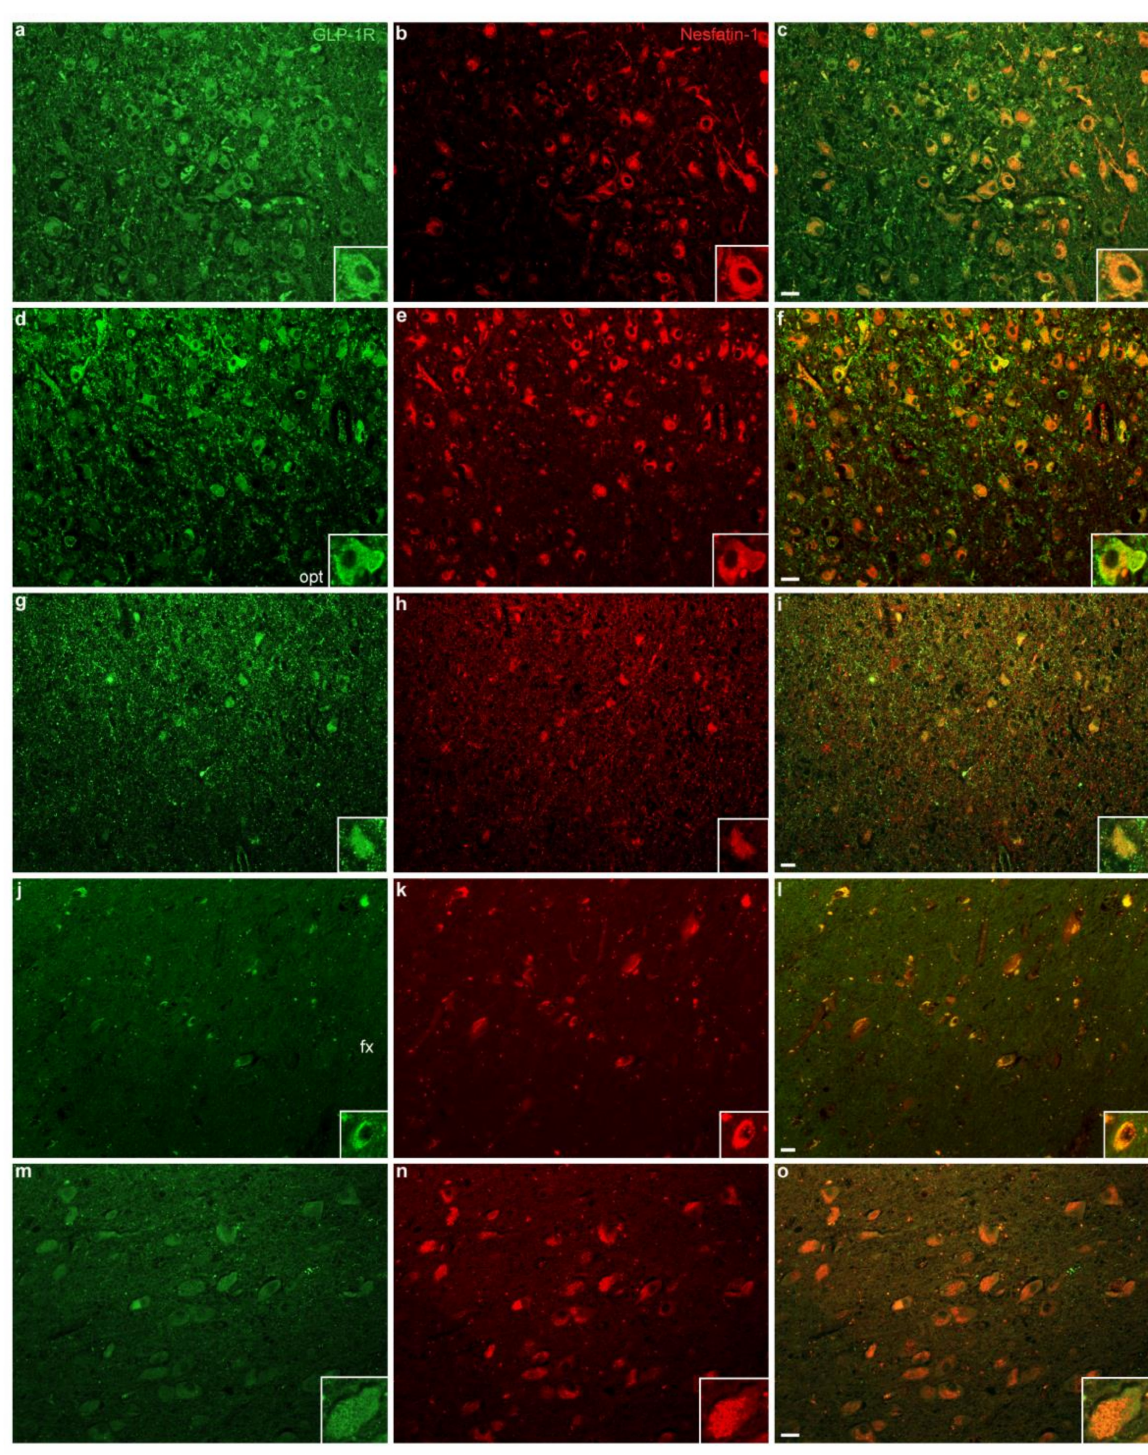
Figure 4. Representative light microscopic fluorescent images depicting GLP-1R and NUCB2/nesfatin-1 colocalization in the human hypothalamus. Representative sections of par- aventricular nucleus ( a – c ), supraoptic nucleus ( d – f ), infundibular nucleus ( g – i ), lateral hypothalamic area ( g – l ), and basal nucleus ( m – o ) double stained for GLP-1R (green) and NUCB2/nesfatin-1 (red). Merged images depict double stained neurons ( c , f , i , l , o ) (200 × ). Insets represent neurons at higher magnification (400 × ). fx, fornix; opt, optic tract. Scale bars indicate 50 µ